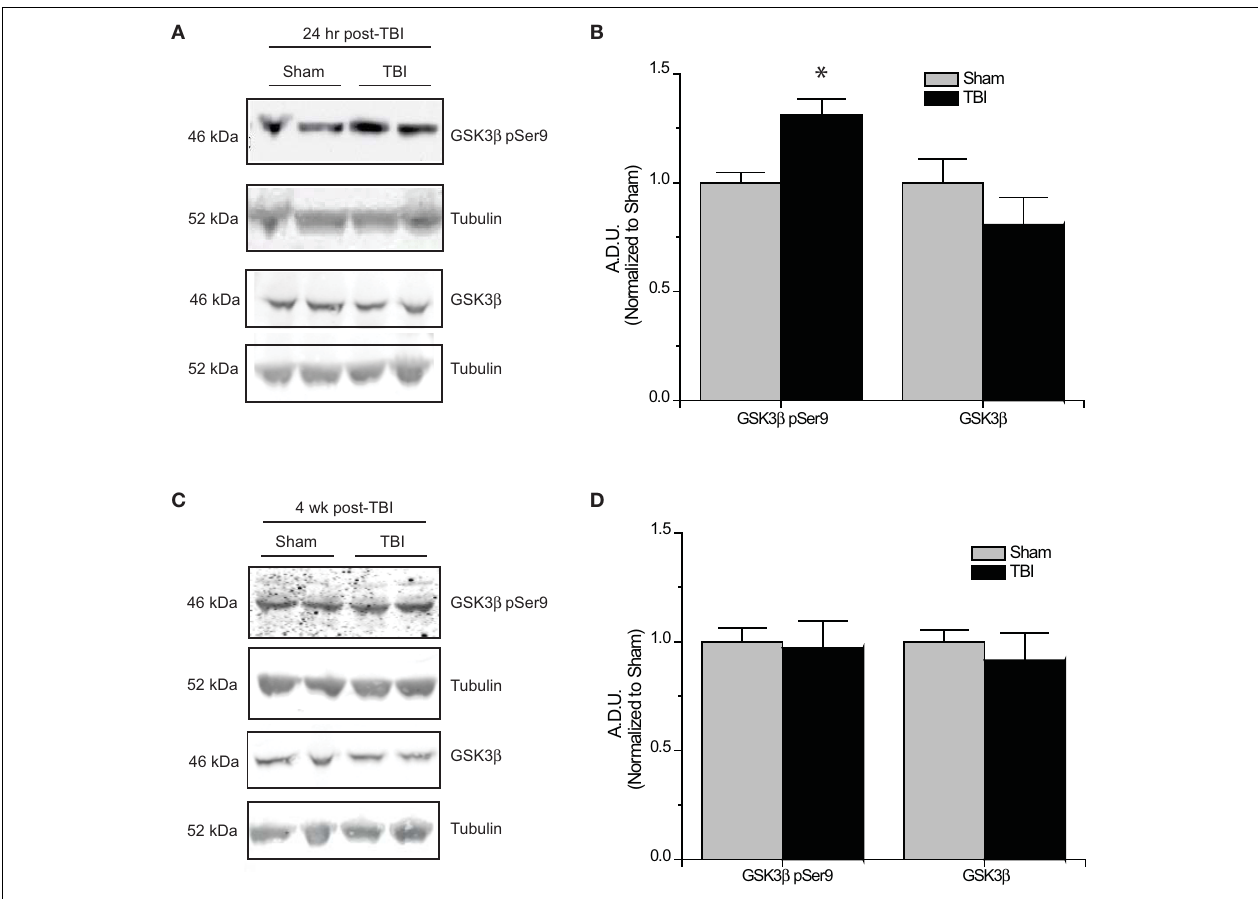
FIGURE 4 | Changes in GSK3 β phosphorylation following TBI. (A) Western blots of phosphorylated and total GSK3 β from hippocampal tissue 24h following TBI. (B) Summary of GSK3 β pSer9 and total GSK3 β levels 24h following TBI. [Data is depicted as arbitrary densitometric units (A.D.U.)]. (C)